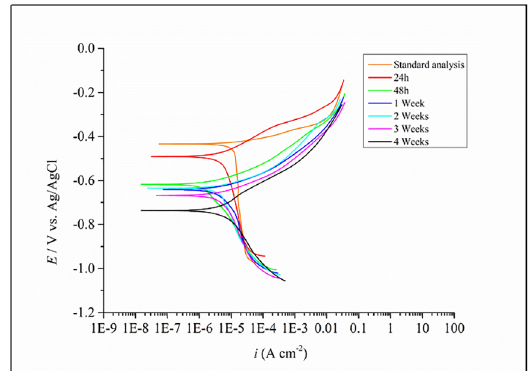
Figure 8 . Potentiodynamic polarization curves for ASTM A 131 grade A36 carbon steel immersed in diesel oil S10 over 30